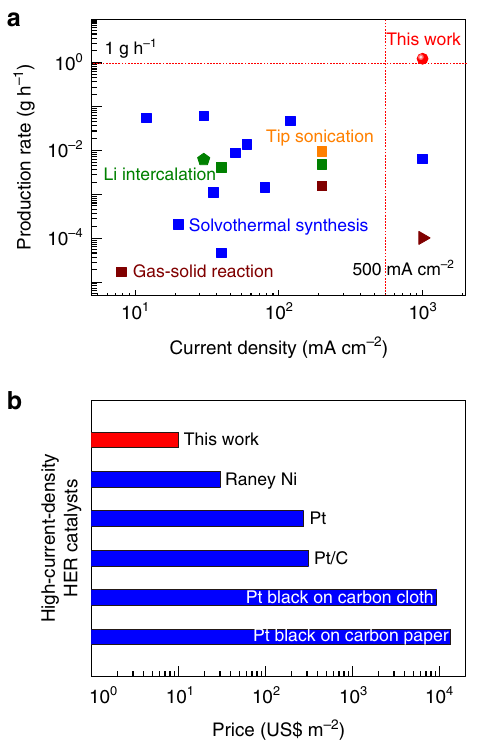
Fig. 5 High-ef fi ciency and low-cost production of MoS 2 mineral-based catalysts from cheap molybdenite concentrate for high-current-density HER. a A comparison of the fabrication rate and highest tested current density of transition metal dichalcogenide-based HER catalysts by different methods. Details for data points are shown in Supplementary Table 1. b A comparison of the catalyst cost compared to commercial electrocatalysts for HER, showing the ultralow cost of the HC-MoS 2 /Mo 2 C catalyst. Note that the support costs of HC-MoS 2 /Mo 2 C, Raney Ni, Pt and Pt/C catalysts are